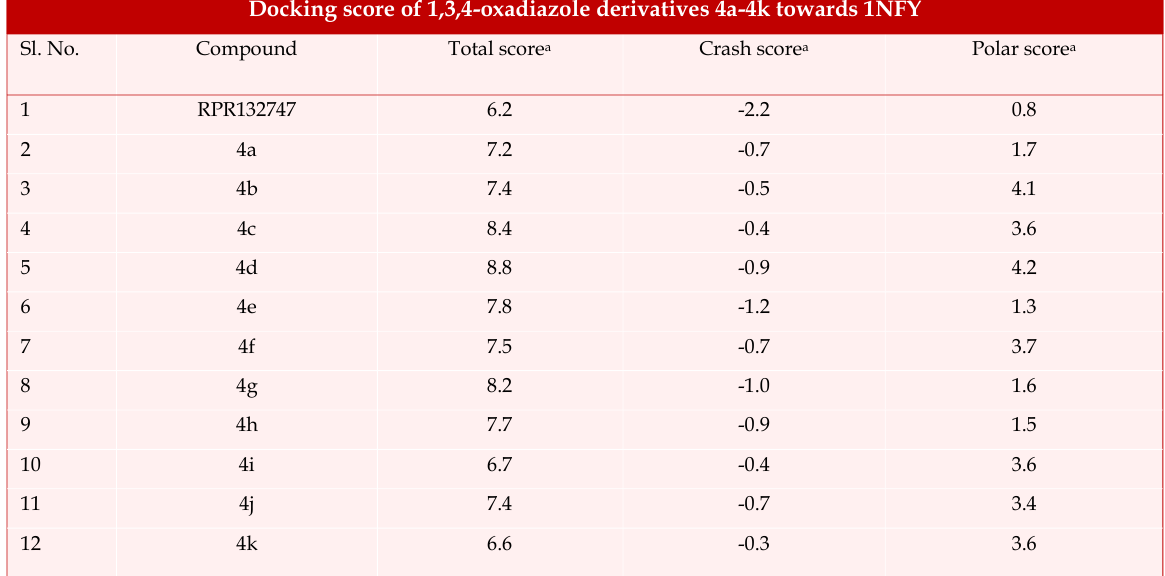
Docking score of 1,3,4-oxadiazole derivatives 4a-4k towards